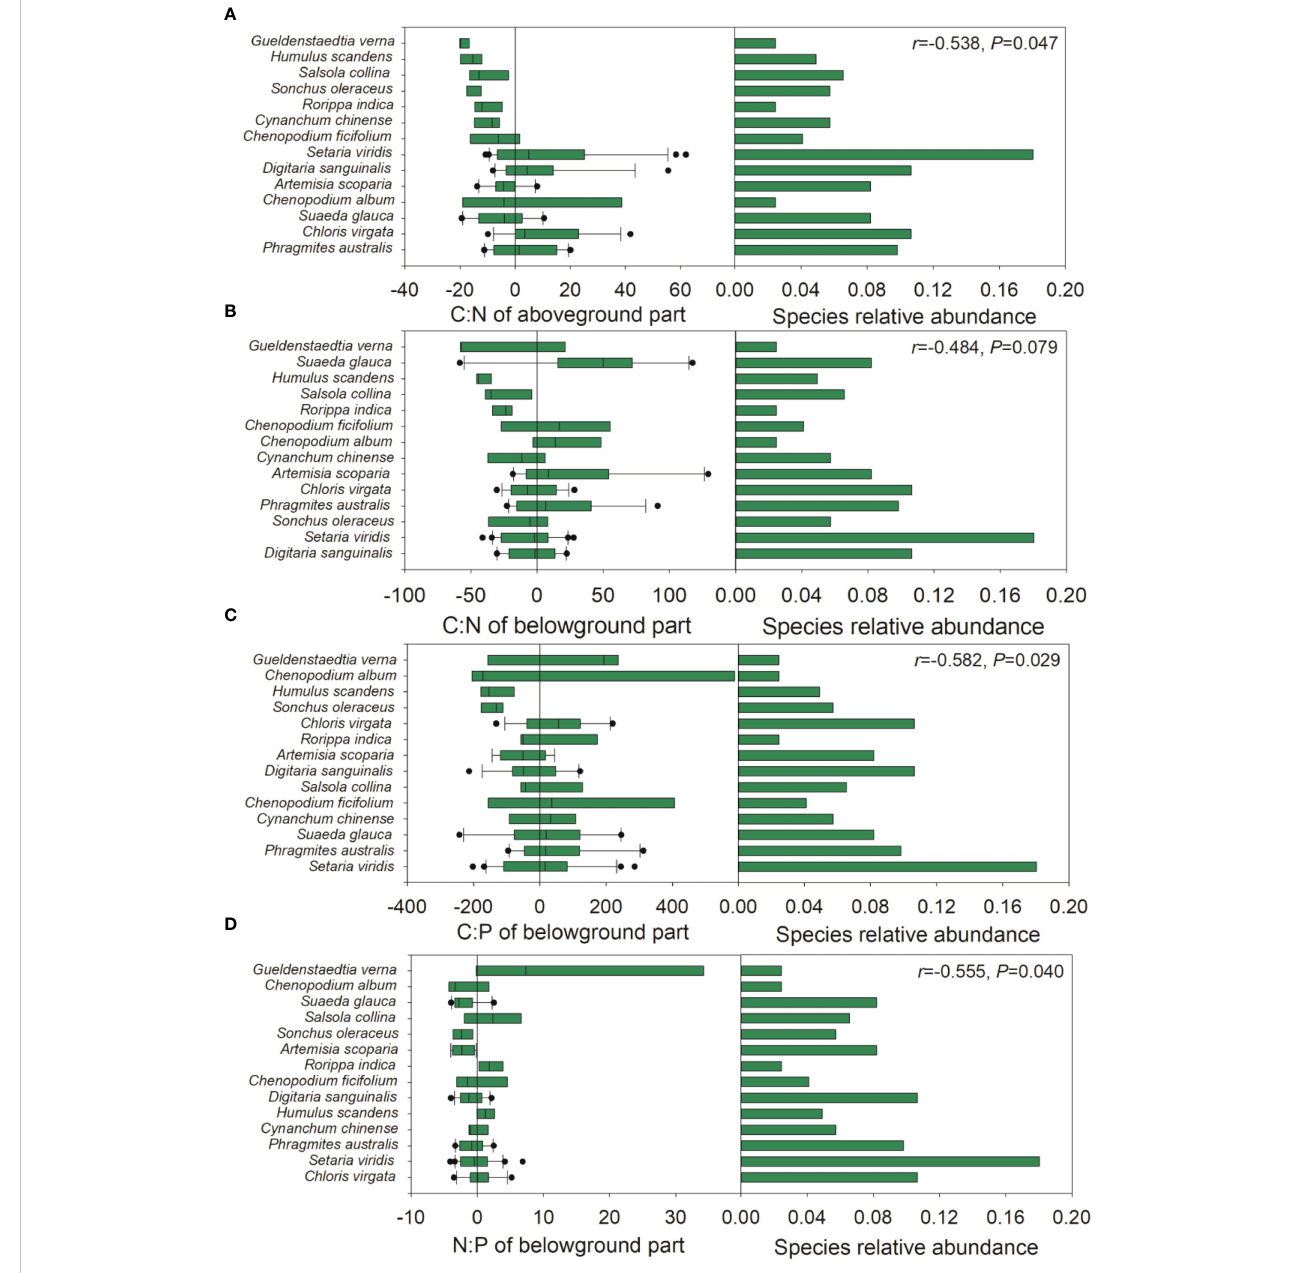
FIGURE 5 The relative position of species C:N:P stoichiometries distribution across sampling sites in the late growth stage. (A) , relative position of the C:N of aboveground part; (B) , relative position of C:N of belowground part; (C) relative position of N:P ratio of belowground part; (D) relative position of N:P of belowground part across sampling sites. Left panel: the x-axis represents the difference between the median C, N, P stoichiometries for each species and the community-weighted mean (CWM) C, N, P stoichiometries for the entire plant community. The y-axis arrays species from bottom to top based on their distance how close to the CWM value. Each boxplot represents the distribution of C, N, P stoichiometries of each species. Right panel: species relative abundance across sampling sites. The r -value of Pearson correlation analysis of the absolute values of the differences between the median C, N, P stoichiometries of each species and the CWM value of the entire community against species relative abundance is provided at the upper